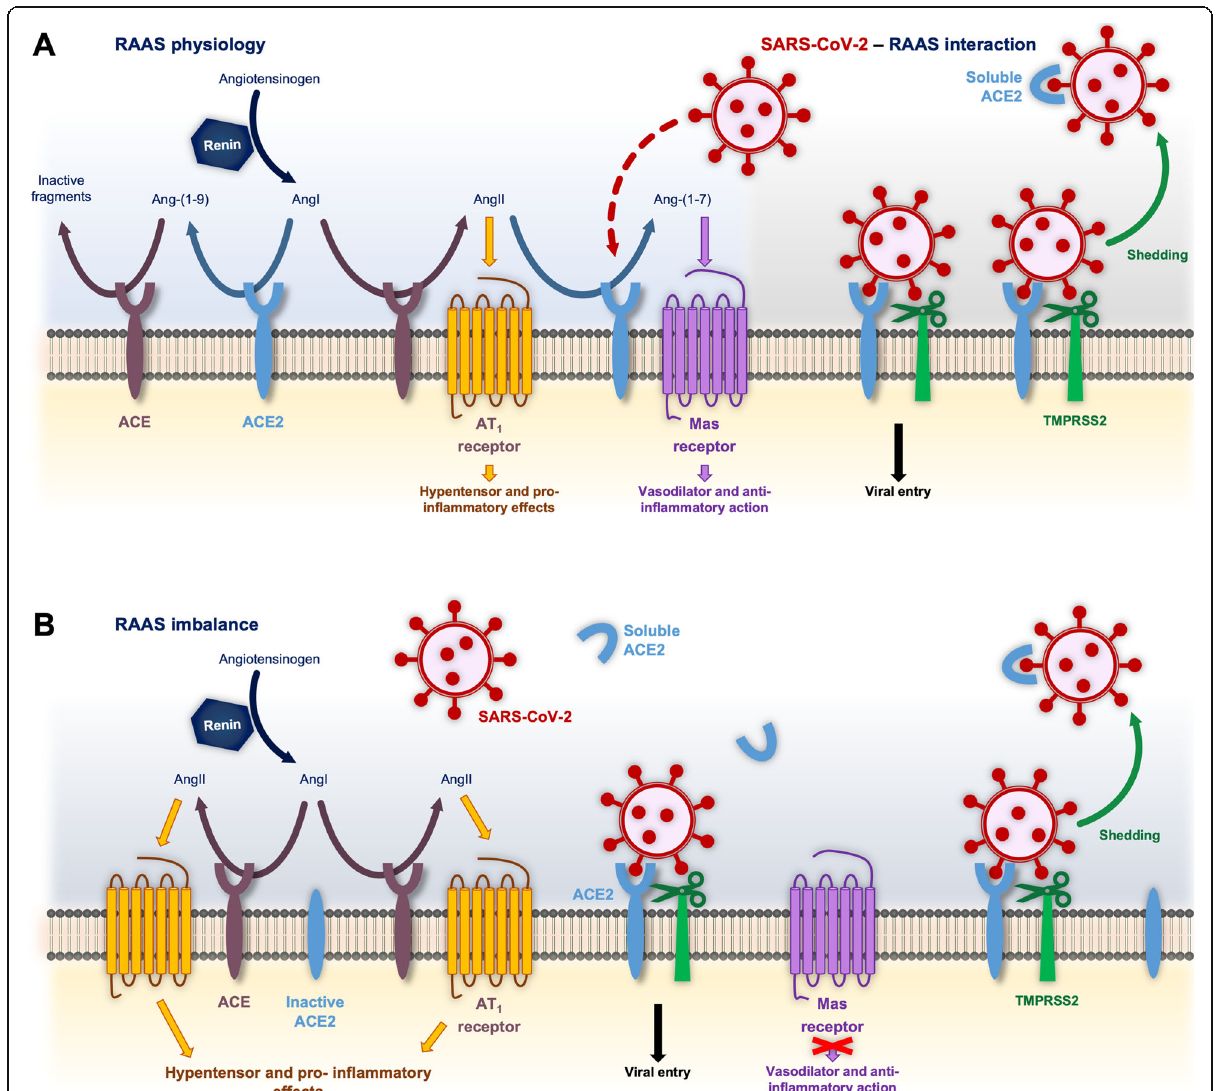
Fig. 1 a Key pivotal modulating and antagonistic roles of ACE and ACE2 in the RAAS, and SARS-Cov-2 binding to ACE2 and TMPRSS2. ACE catalyzes the conversion of AngI into AngII, thereby inducing hypertensive and pro-inflammatory effects, while ACE2 mediates the formation of angiotensin-(1 – 9) from AngI. ACE2 also counters ACE activity by reducing AngII bioavailability and increasing Ang-(1 – 7) formation, which acts as a vasodilator and exerts antiinflammatory activities through Mas receptors. SARS-CoV-2 interacts and downregulates ACE-2. b In this context, an imbalance in ACE2/Ang-(1 – 7) and ACE/AngII axes would be critical in the development of severe COVID-19